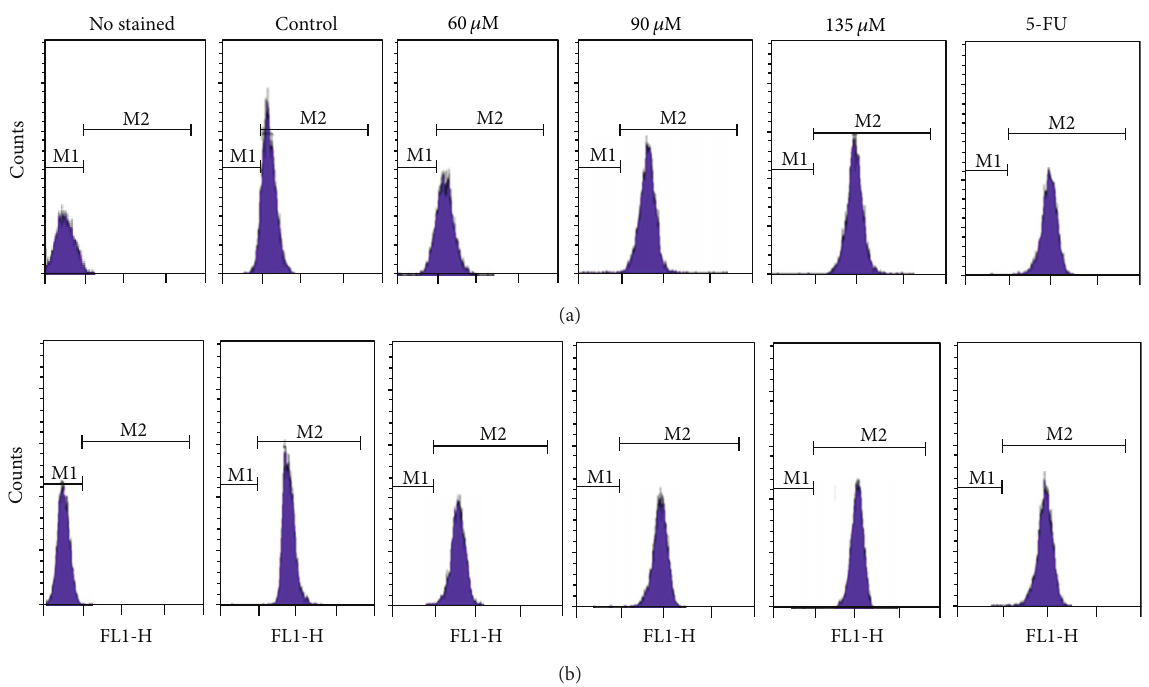
Figure 11: Distribution map of mitochondrial membrane potential with complex 1 (bottom) and complex 2 (top) for 48h.